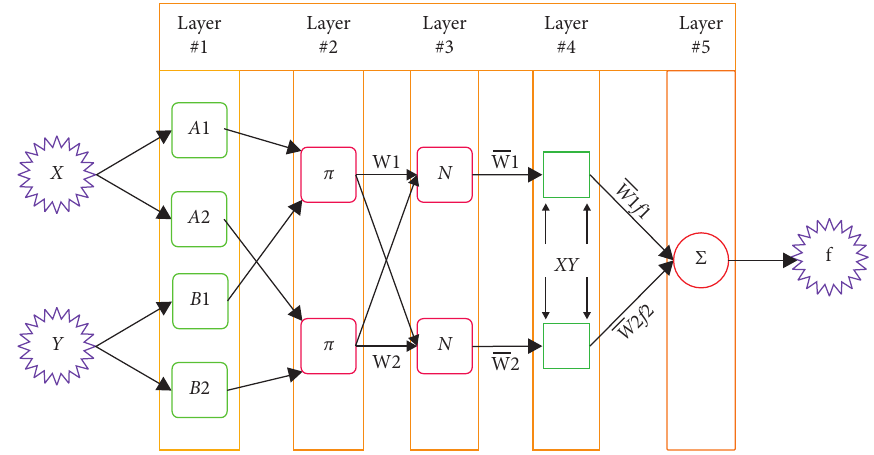
Figure 2: The conceptual mapping of adaptive neuro-fuzzy inference system